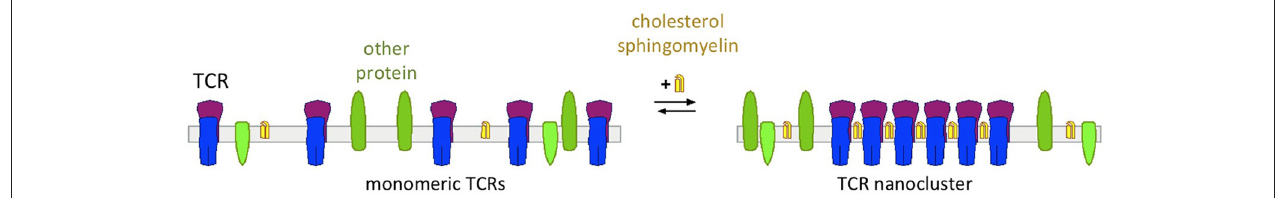
FIGURE 3 | Cholesterol’s function of regulating nanoclustering of the TCR. With low levels of cholesterol and sphingomyelin TCRs are expressed as monomers on the cell surface (left)—as it is the case in naïve T cells. With increasing concentrations of cholesterol and sphingomyelin, these lipids bind to the TCR and cause TCR nanoclustering—as it is the case in activated and memory T